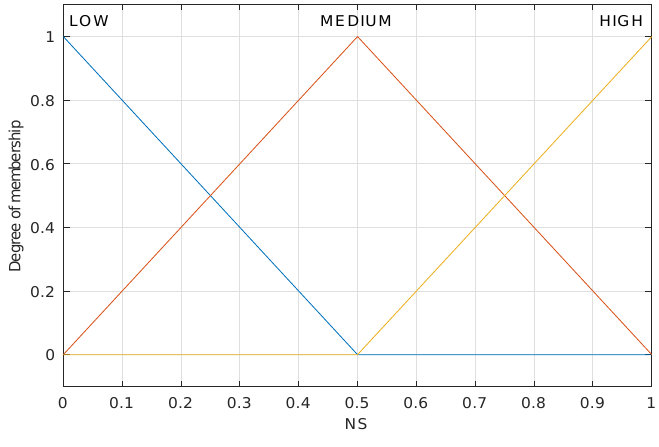
Figure 3. Membership function of